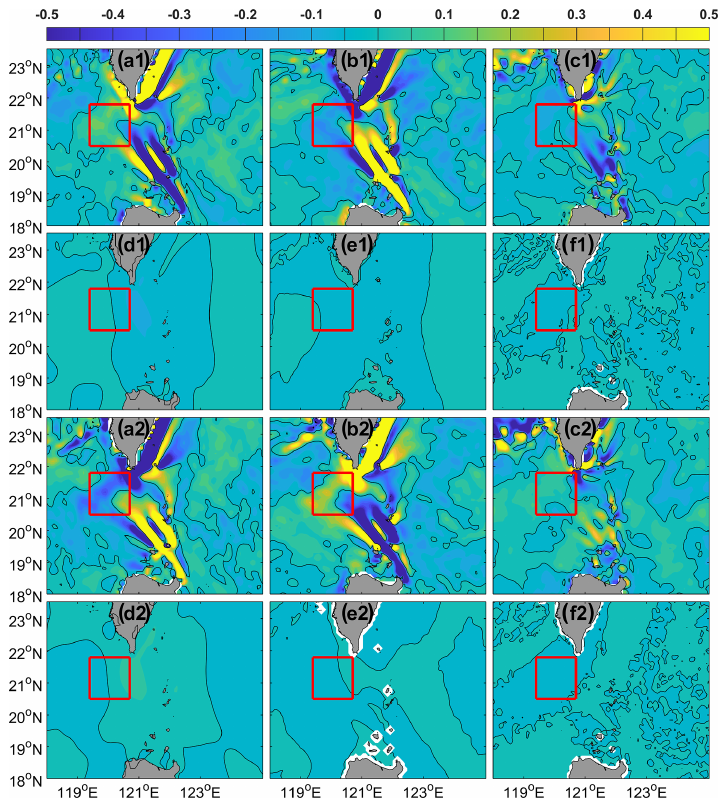
Figure 13. Vorticity budget equation for (a1–f1) AE mode of counter-rotating eddy pair and (a2–f2) CE mode of counter-rotating eddy pair. Panels (a1) and (a2) represent the zonal advection term, (b1) and (b2) the meridional advection term, (c1) and (c2) the stretching term, (d1) and (d2) the beta term, (e1) and (e2) the baroclinic term, and (f1) and (f2) the diffusion term. Units are 10 − 10 s − 2 . Red boxes on west side of LS border cover 20.5–21.8 ◦ N, 119.4–120.7 ◦ E, and represent location of CE or AE on west side of LS. Black solid line represents the zero contour. Figure based on HYCOM data.